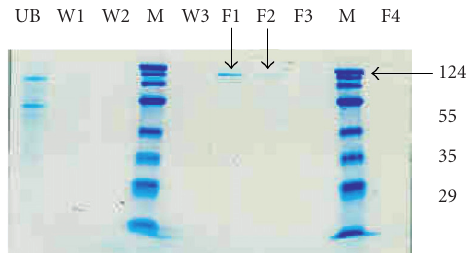
Figure 1. Methanol utilization (mut) phenotype of transformed Pichia pastoris X-33. A represents colony of P pastoris control strain P pastoris /LacZ/ β -galactosidase (mut + ) strain. B repre- sents colony of P pastoris /HSA/albumin (mut s ). Plate (1): mini- mal media with dextrose (MMD). Plate (2): minimal media with methanol (MMH). UB W1 W2 M W3 F1 F2 F3